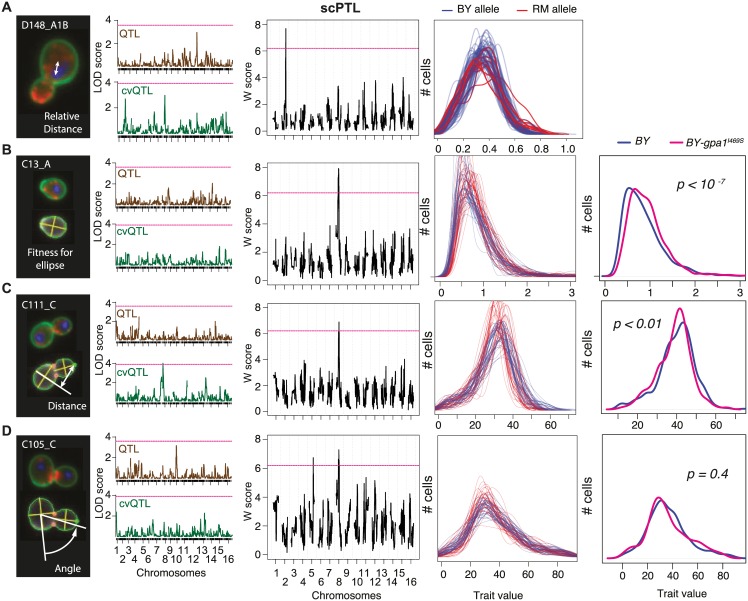
Mapping single-cell probabilistic traits of cellular morphology.For each of 59 recombinant BYxRM yeast strains, four quantitative traits were measured on ~200 individual cells [22]. From left to right: description of the trait; results from QTL scans applied to the mean (brown) or coefficient of variation (green) of the trait; results from scPTL scan (pink dashed line: genome-by-phenome significance threshold at FDR = 10%; single-cell trait density functions computed from the data, where each line corresponds to a recombinant strain (color: genotype at scPTL); when relevant, single-cell trait density functions of nearly-isogenic BY strains differing for one non-synonymous SNP in the GPA1 gene are shown (p: statistical significance of the corresponding two-sample Kolmogorov-Smirnov test). A) Trait D148_A1B is the distance between the nuclear brightest point and the mother center, relative to the mother size. An scPTL was detected on chromosome 2. B) Trait C13_A is the fitness of the cell outline to the best adjusted ellipse. C) Trait C111_C is the distance between the bud tip and the extension of the mother short axis. D) Trait C105_C corresponds to the position of the budding site. It is the angle between the long axis of the mother cell and the line defined by the mother center and the middle point of neck.